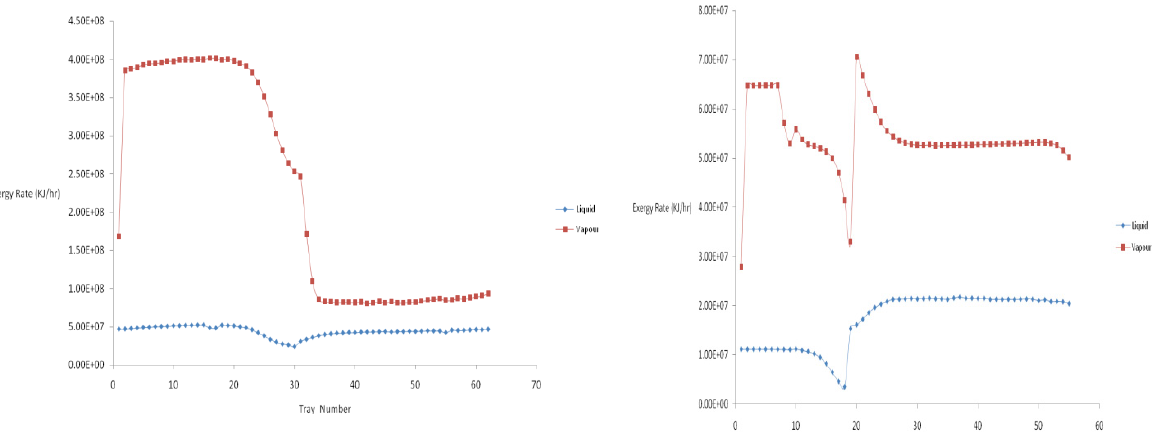
Figure 12. Profile of exergy rate versus tray number for Depropanizer of base case, 80 o C